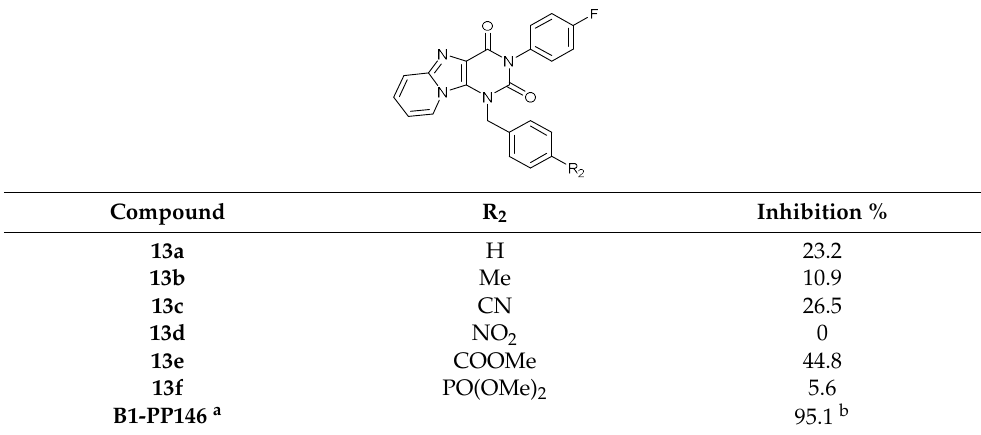
Table 4. Mtb ThyX inhibition at 200 µM by the NADPH oxidase assay of benzyl analogues 13a-f .